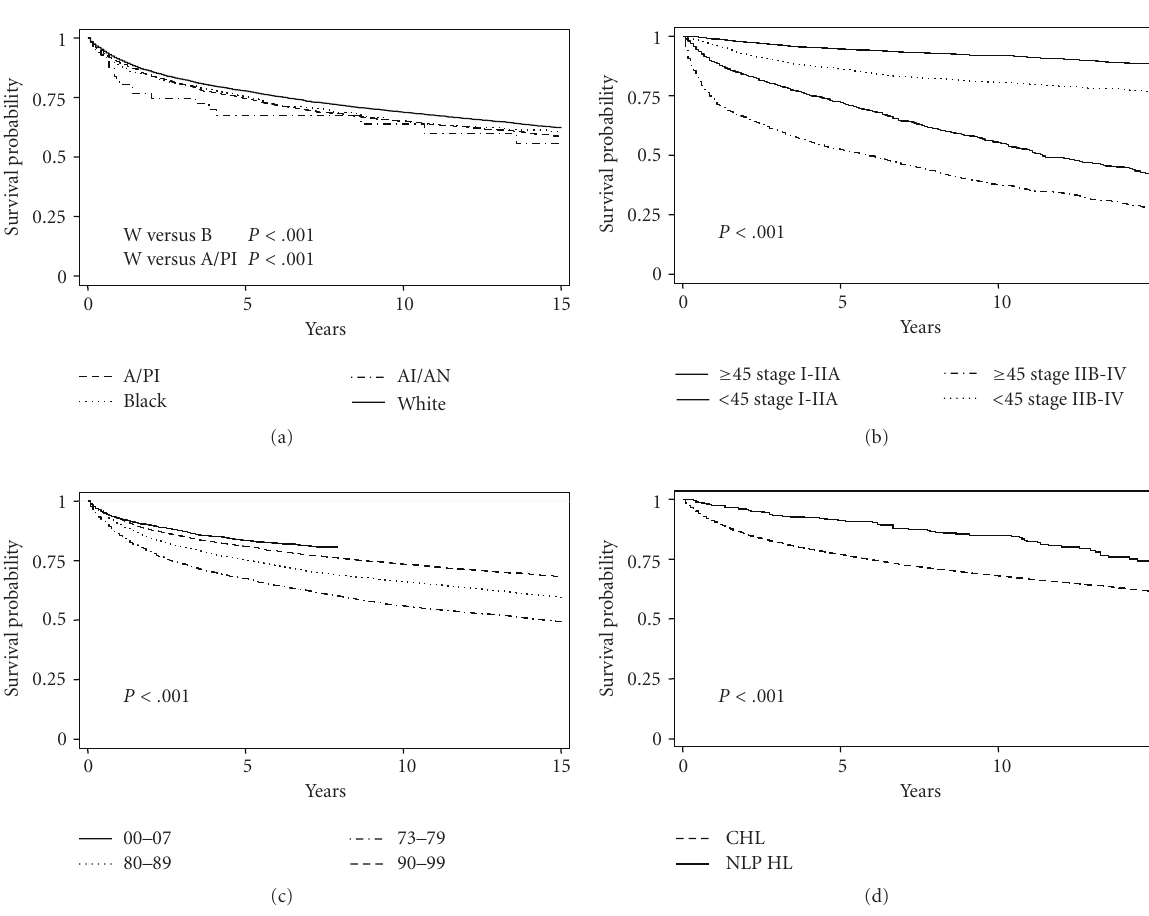
Figure 3: Kaplan-Meier Survival Curves of HL Patients. (a) Survival curves by race. (b) Survival curves by age at diagnosis ( < 45 versus ≥ 45 years) and stage (Stage I-IIA versus Stage IIB-IV). (c) Survival curves by era of diagnosis. (d) Survival curves for CHL and NLP